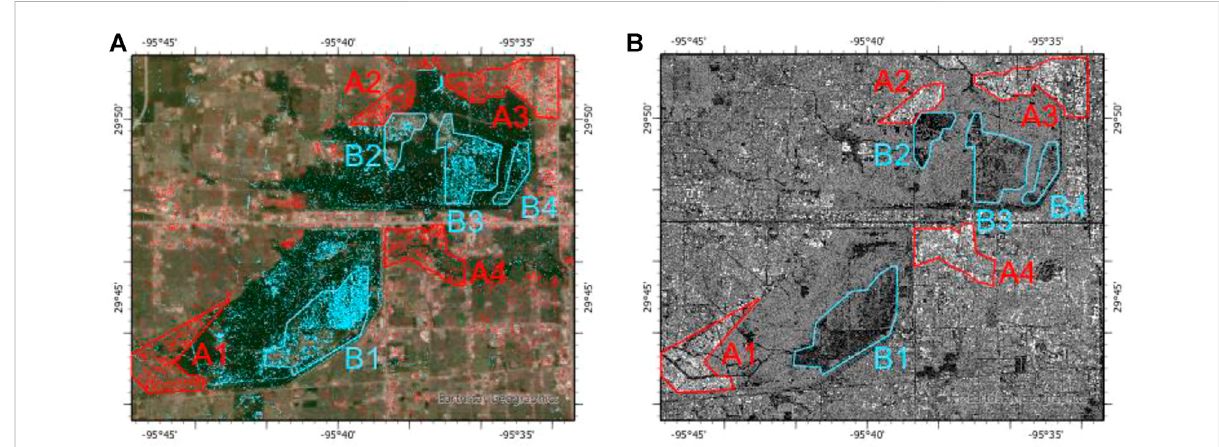
FIGURE 6 Extracted fl ooded areas from (A) optical and (B) SAR images in the Houston fl ood case. A1 Cinco Ranch Southpark, A2 Bear Creek Central, A3HeritageBusinessPark,A4EnergyCorridor;B1GeorgeBushPark,B2Addicks/ParkTen(West),B3Addicks/ParkTen(Middle),B3Addicks/ParkTen (East).